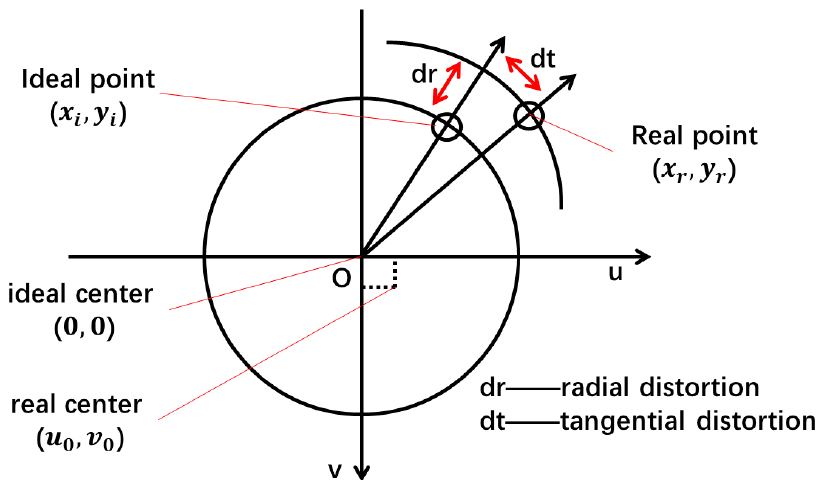
Figure 2. Internal camera distortion